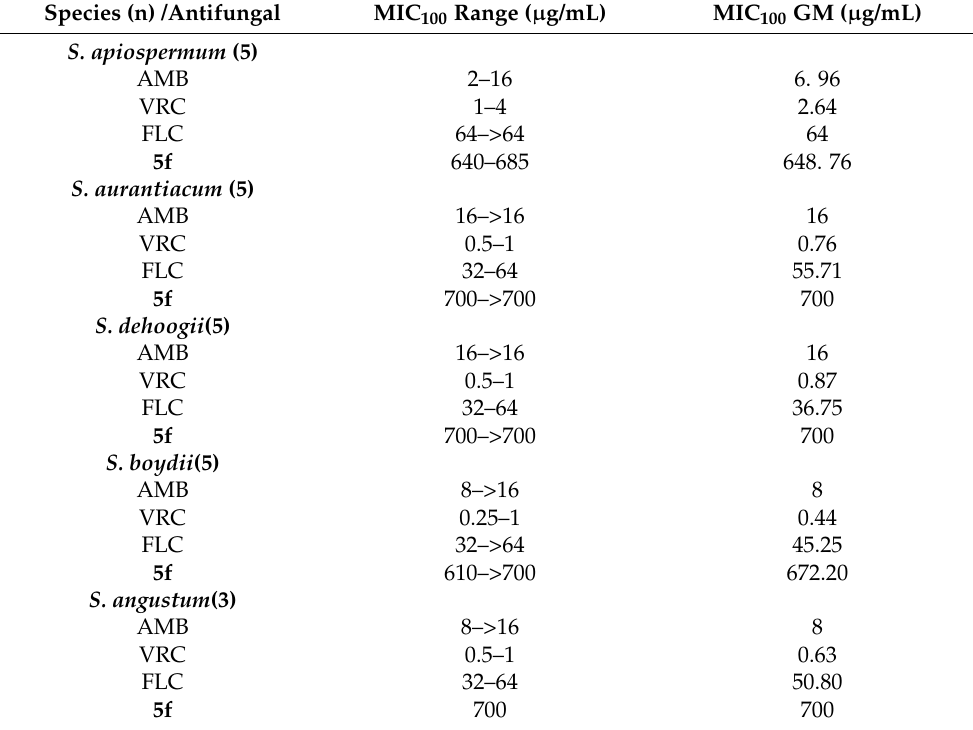
Table 4. In vitro susceptibilities of 23 strains of Scedosporium against antifungal drugs and com- pound 5f .